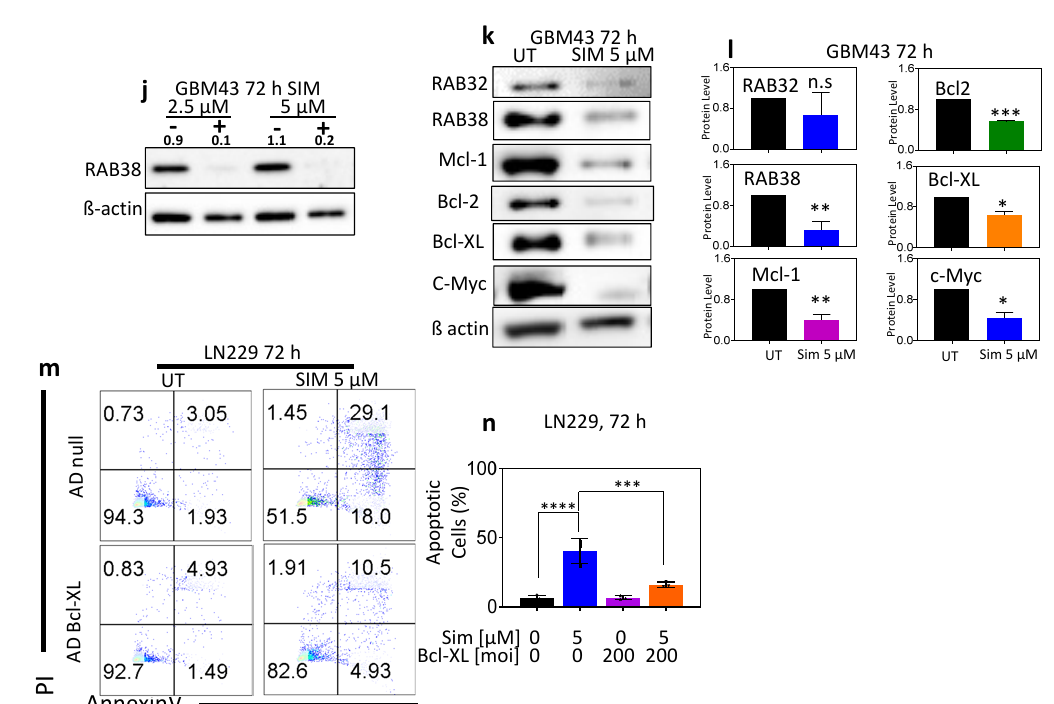
Figure 6. Simvastatin causes a reduction in cellular viability and downregulates RAB38, RAB32, Mcl-1, Bcl-2, Bcl-xL, and c-Myc protein expression. ( a – c ) LN229 ( a ), T98G ( b ), and GBM43 ( c ) glioblastoma cell lines were treated with increasing concentrations of simvastatin for 72 h. Cellular viability was determined by CellTiter-Glo assay and the IC50 values were calculated based on a nonlinear regression analysis. Data are presented as mean and SD, n = 3. ( d – l ) LN229 ( d – f ), T98G ( g – i ), and GBM43 ( j – l ) were treated with simvastatin at two different concentrations for 72 h. Whole-cell protein extracts were analyzed by Western blot for RAB38, RAB32, Mcl-1, Bcl-2, Bcl-xL, and c-Myc. β -Actin Western blot analysis was performed to confirm equal protein loading. Protein quantification was analyzed through ImageJ. Representative plots and a histogram with statistical analysis are presented ( n = 3). ( m – n ) LN229 cells transduced with a control adenovirus or an adenovirus encoding Bcl-xL were treated with simvastatin, stained with annexin V/propidium iodide at 72 h following treatments, and analyzed by flow cytometry. Representative plots and a histogram with statistical analysis are presented ( n = 3). * p < 0.05; ** p < 0.01; ***/**** p < 0.001, n.s. means not